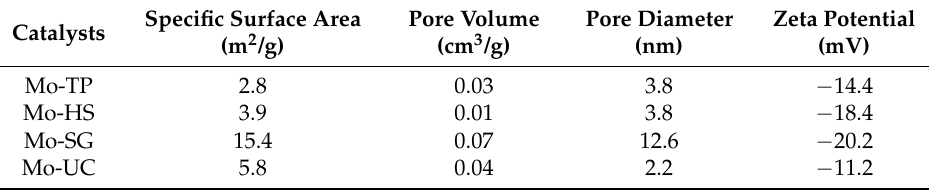
Table 1. The surface area, pore diameter, and pore volume of the Mo/ZnAl-LDH catalysts.